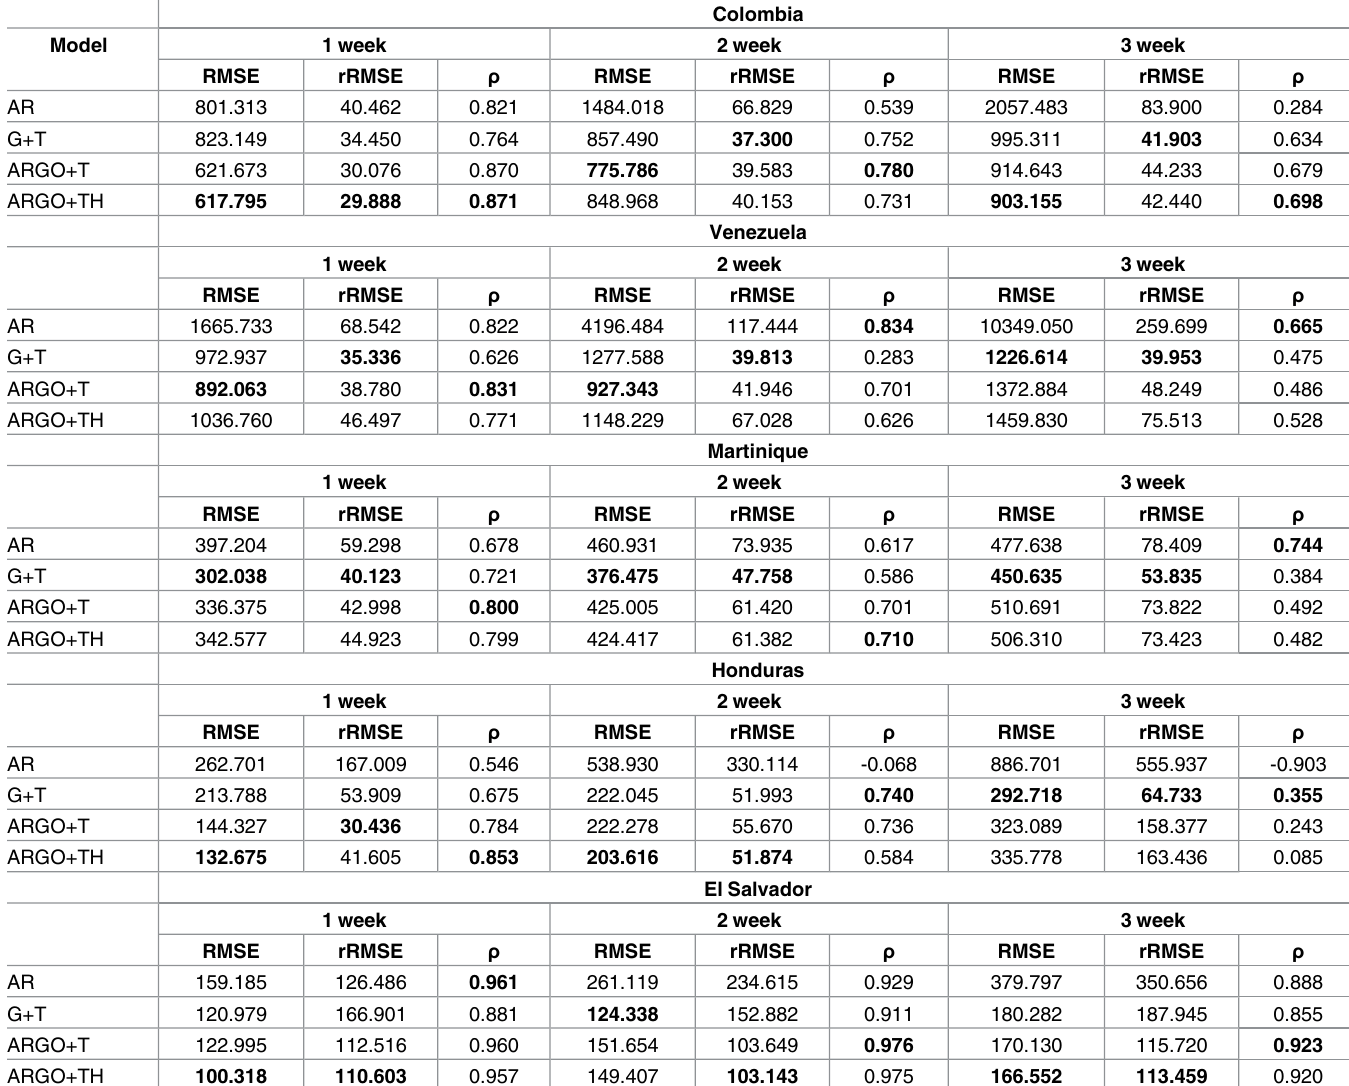
Table 2. RMSE, rRMSE, and Pearson’s correlation coefficient ( ρ ) for 1-, 2-, and 3-week ahead out-of-sample predictions. Models includeTwitter data where available(Colombiaand Venezuela).The best fit metric for each week-ahead predictionis show in